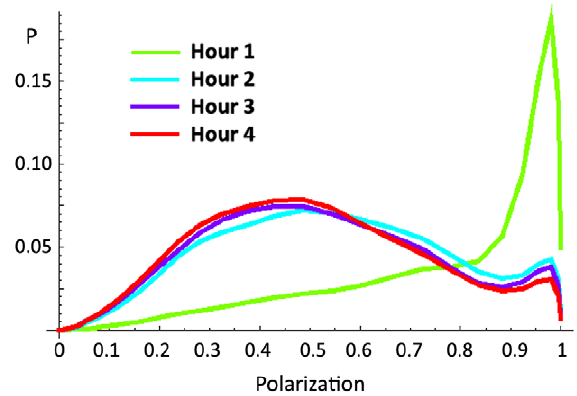
Figure 2. Density distributions of polarization by hour for Experiment 2. Summed polarization distributions for each hour of a single, 4 hour, exposure to the testing tank. Distributions are averaged across the entire session (1800 frames per session) and all groups (8 groups of 8 fish each). A similar effect of habituation is seen to that observed in Figure 1, with increased shoaling and decreased schooling as time passes (K-S test, hour 1 vs. hours 2–4, all p , 0.001; see Table S2).